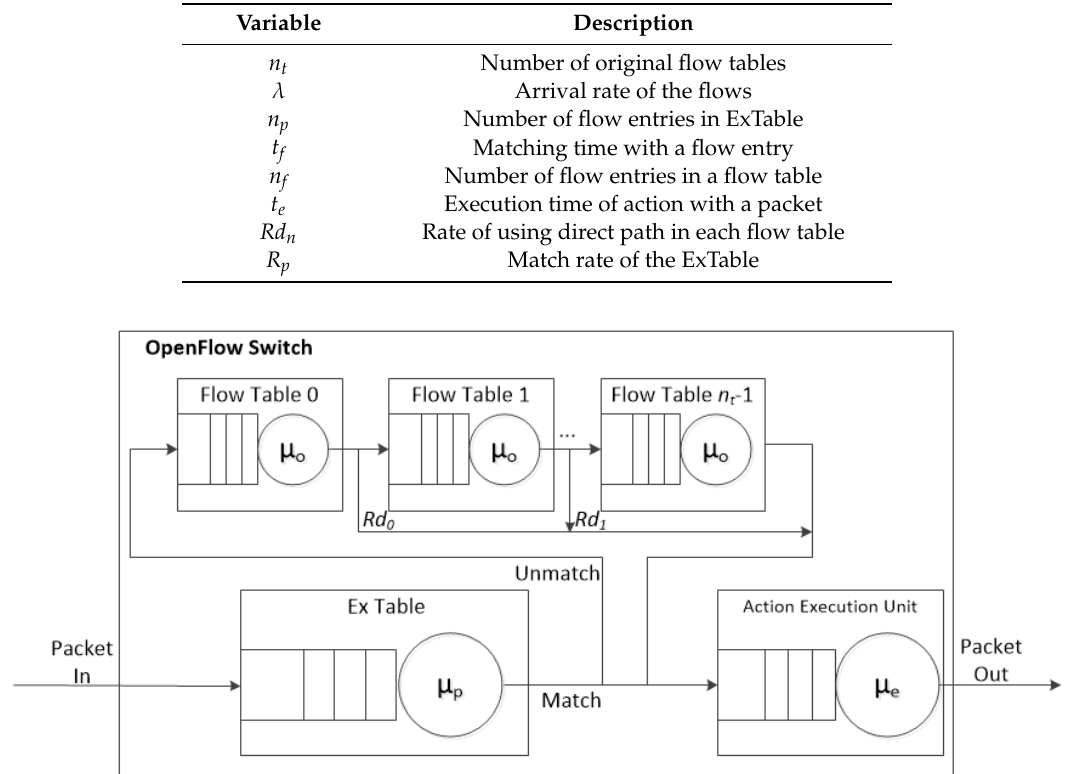
Table 7. The variables used in the queueing model.